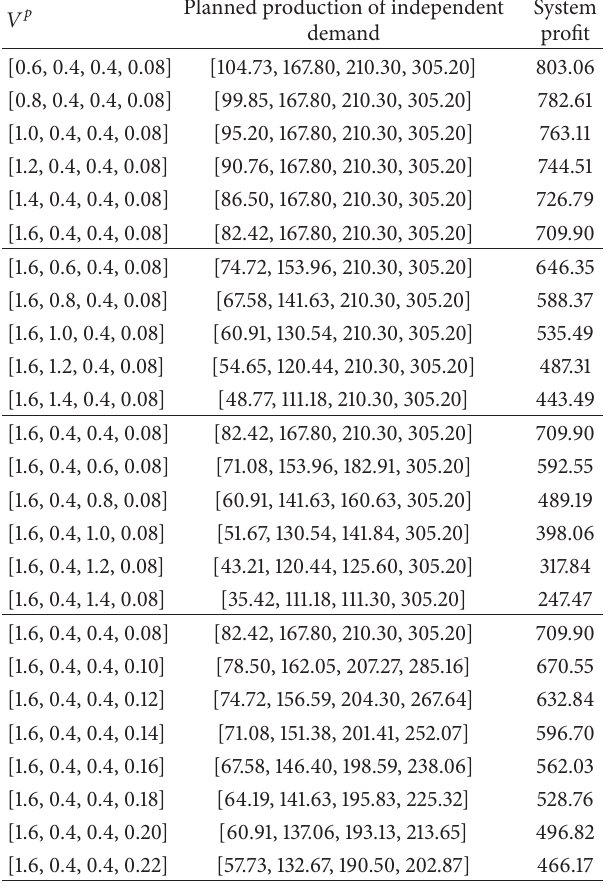
Table 1: Production planning and system profits sensitivity analysis to 𝑉 𝑝 .